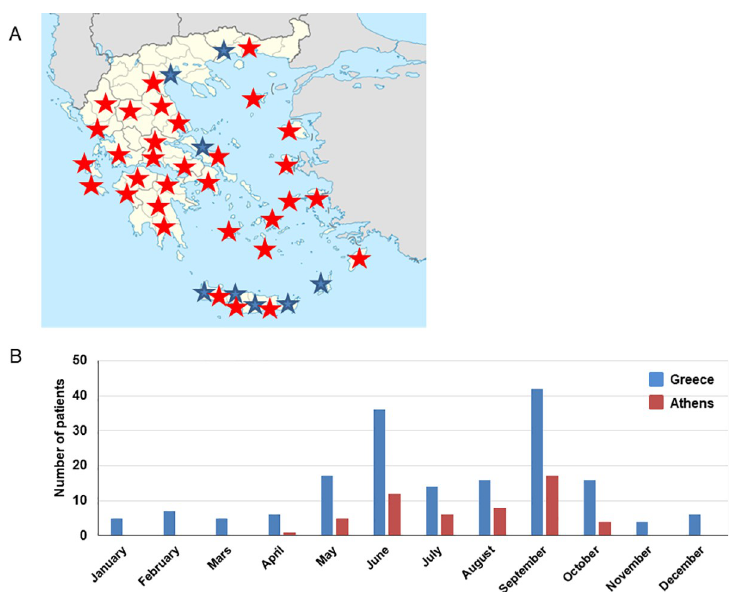
Fig 1. A, Murine typhus patients throughout Greece; B, Seasonal distribution of patients diagnosed for murine typhus, in Greece and in Athens, 2012–2019. Red stars: present murine typhus cases. Blue stars: previous murine typhus reported cases based on the researched of PubMed for peer-reviewed, articles published in English up to June 2020. The search terms were combinations of “murine typhus”, “ Rickettsia typhi ” and